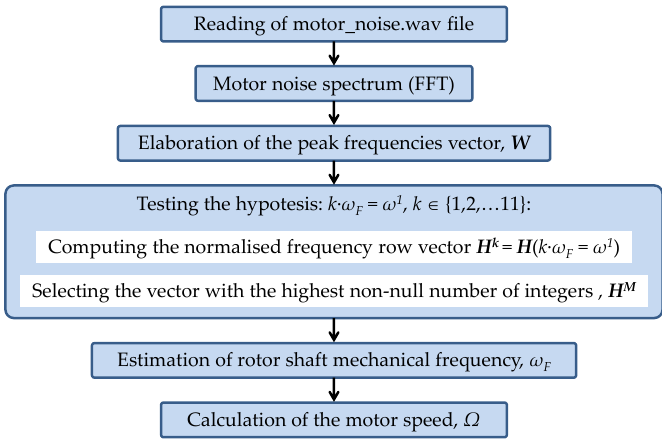
Figure 4. Flowchart of the speed estimation method.